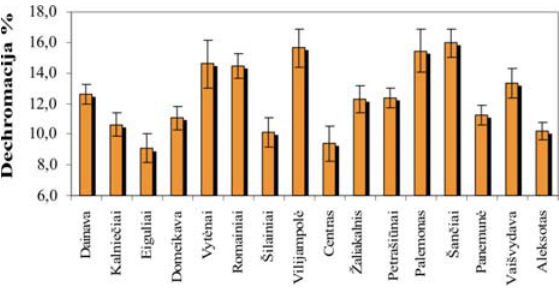
Fig. 5. Average crown defoliation of sampled trees